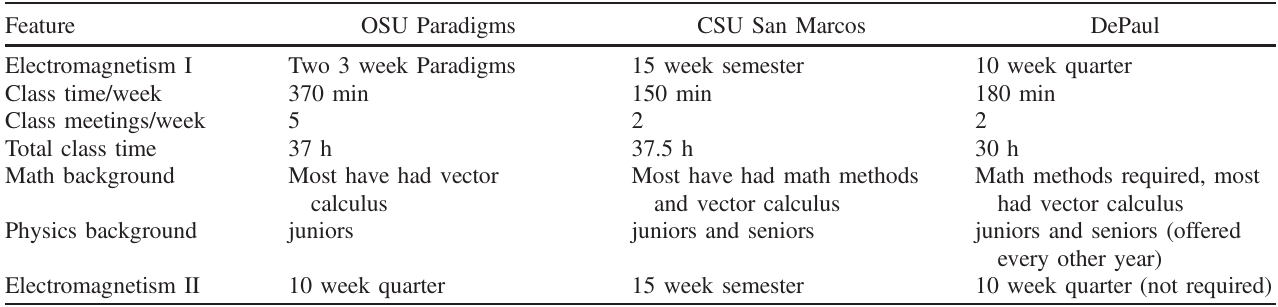
TABLE III. A comparison of the features of each institution.